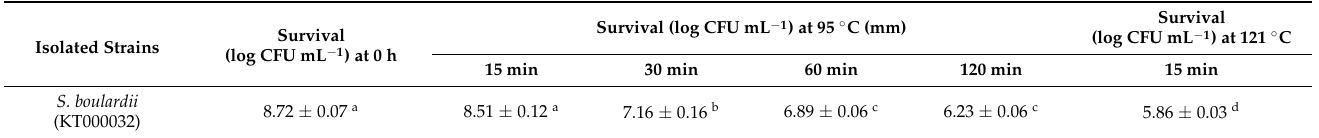
Table 10. Heat stability of S. boulardii strains towards heat treatment at 95 ◦ C and 121 ◦ C with different periods.